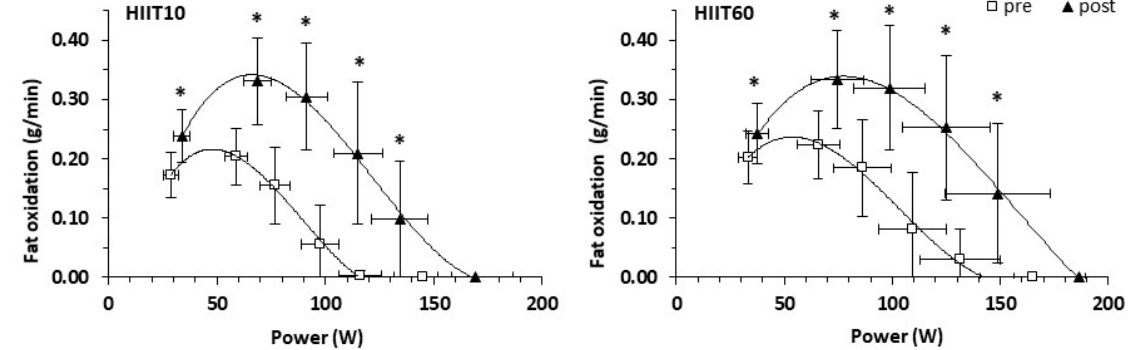
Figure 2. Fat oxidation rate during a progressive submaximal exercise test before (pre) and after (post) training for the HIIT10 and the HIIT60 groups. * p < 0.001 for pre- vs. post-training. Points represent means, and error bars represent standard deviation.